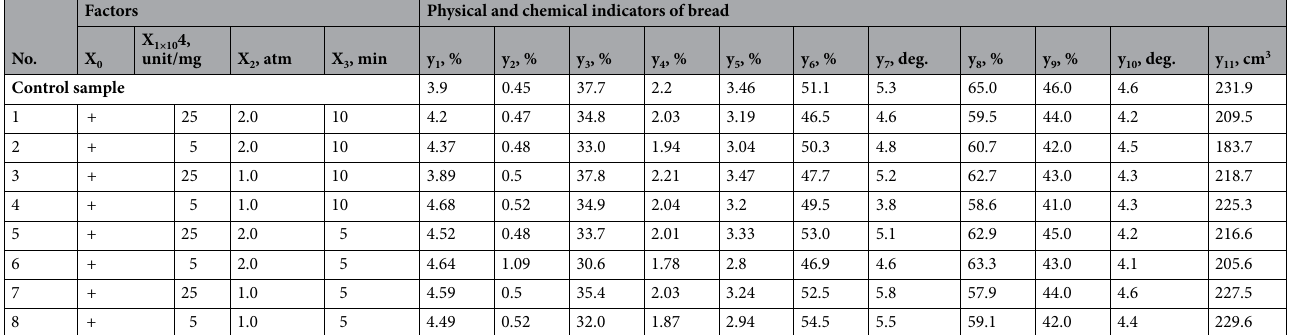
Table 4. Wholegrain bread made from class 3 wheat. y 1 —protein, y 2 —fats, y 3 —carbohydrates, y 4 —ash content, y